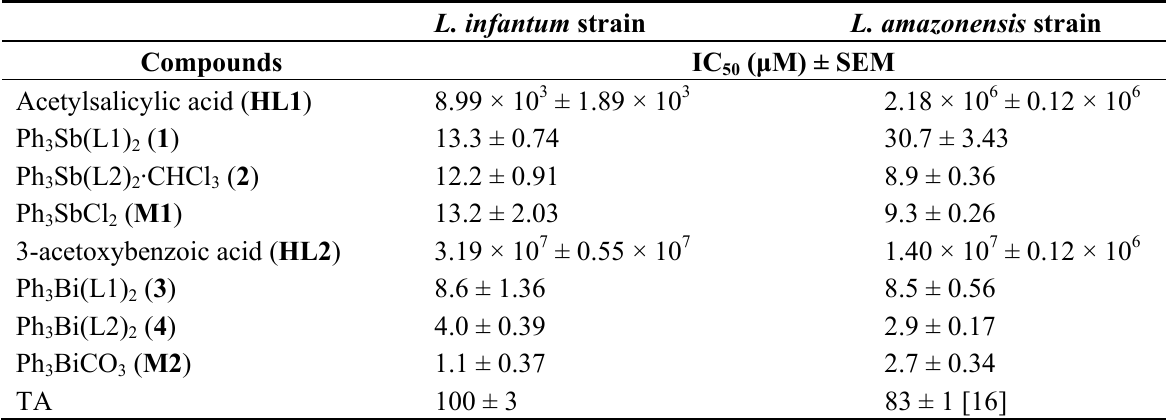
Table 3. Inhibitory concentrations of complexes 1 – 4 , metal salts Ph and the free ligands acetylsalicyclic acid (HL1) and 3-acetoxybenzoic acid (HL2) against New World L. amazonensis and L. infantum species